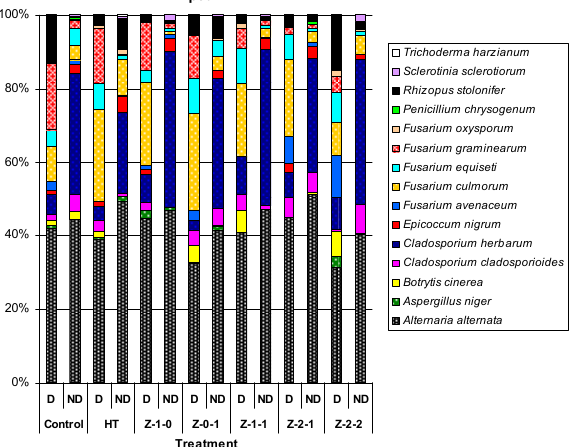
Figure 2. The percentage each species of microscopic fungi cultured for the disinfected (D) and non-disinfected (ND) grains of pea, mean for 2010–2012. Penicillium chrysogenum Thom, Sclerotinia sclerotiorum (Lib.) de Bary and Trichoderma harzianum Rifai were isolated only from non-disinfected (ND) grains.